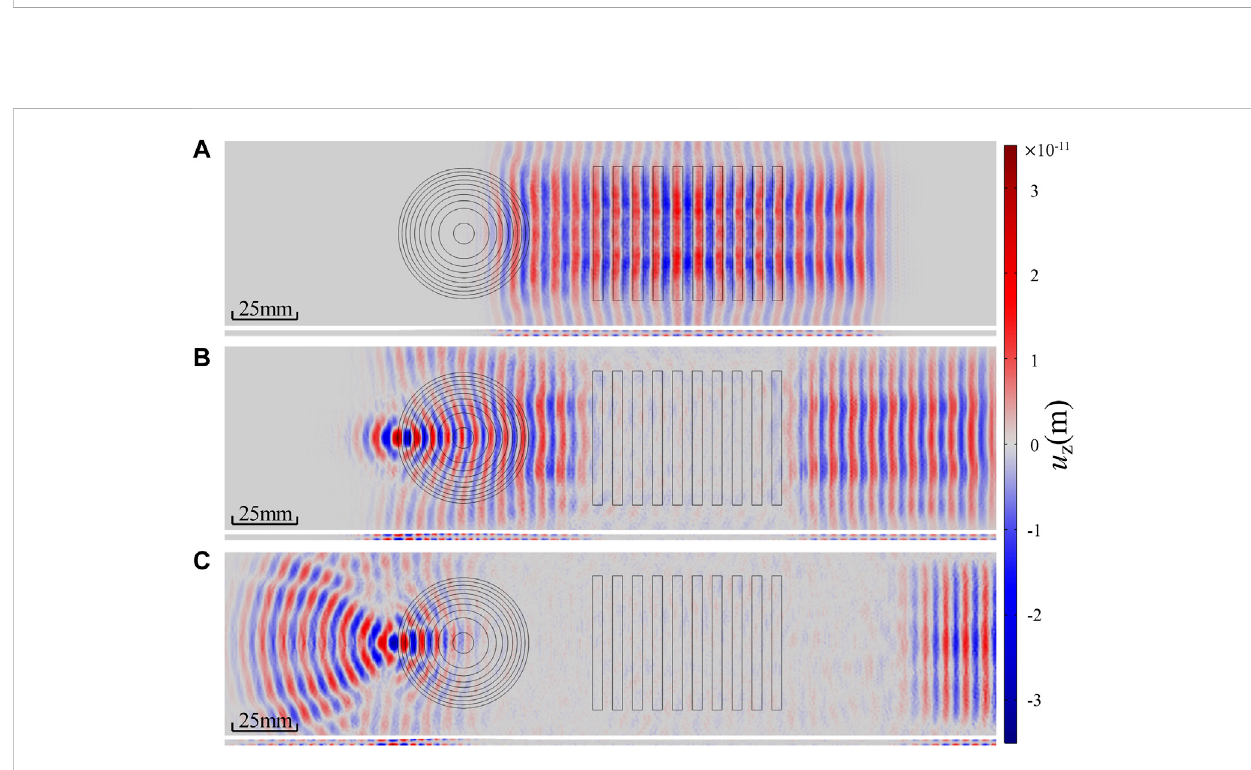
FIGURE 7 The focusing phenomenon of the S2-wave-based Luneburg lens at 1.9 MHz: (A) t = 15 μ s, (B) t = 30 μ s and (C) t = 45 μ s.